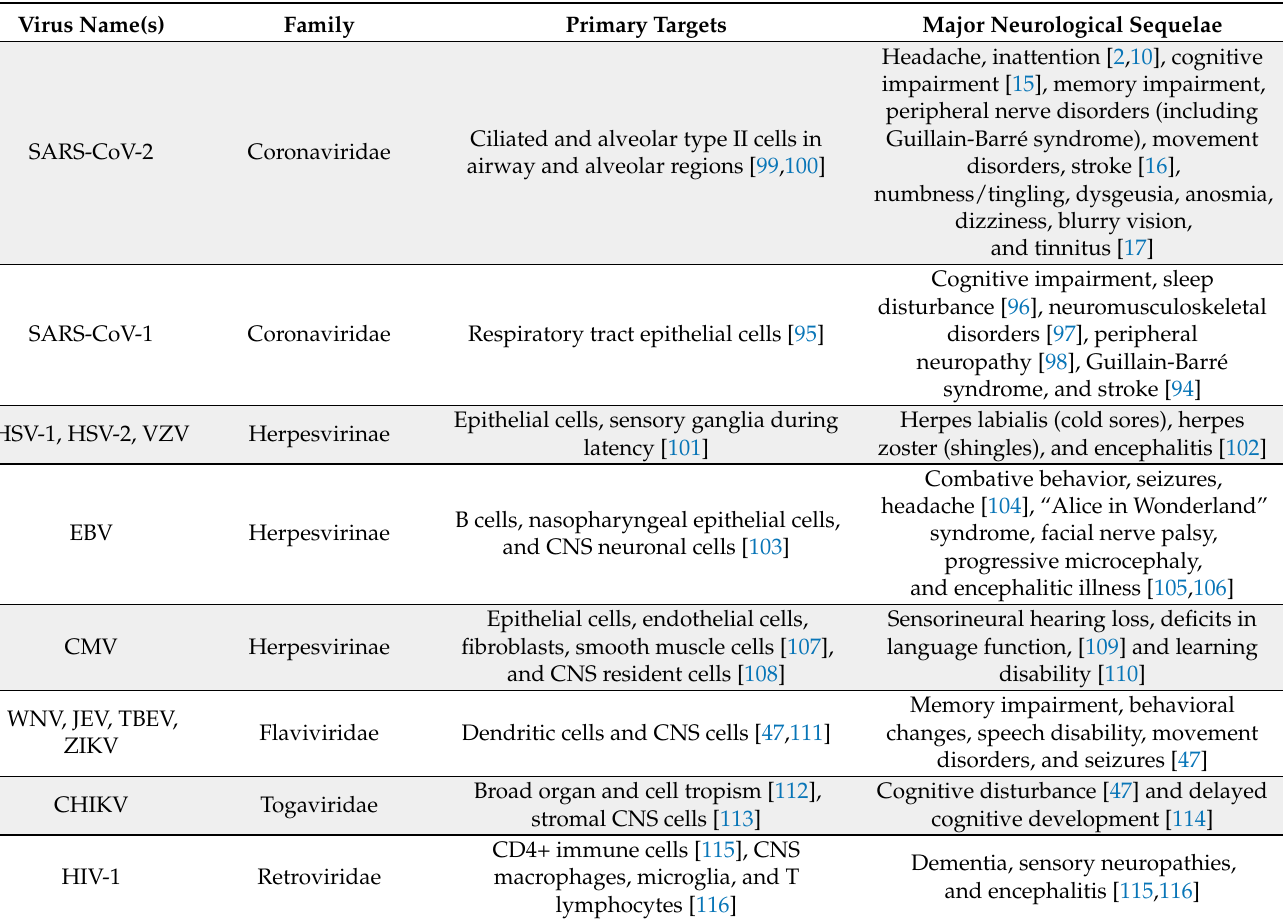
Table 1. Overview of viruses associated with “long-haul” neurological symptoms. Primary infection targets and major neurological sequelae are